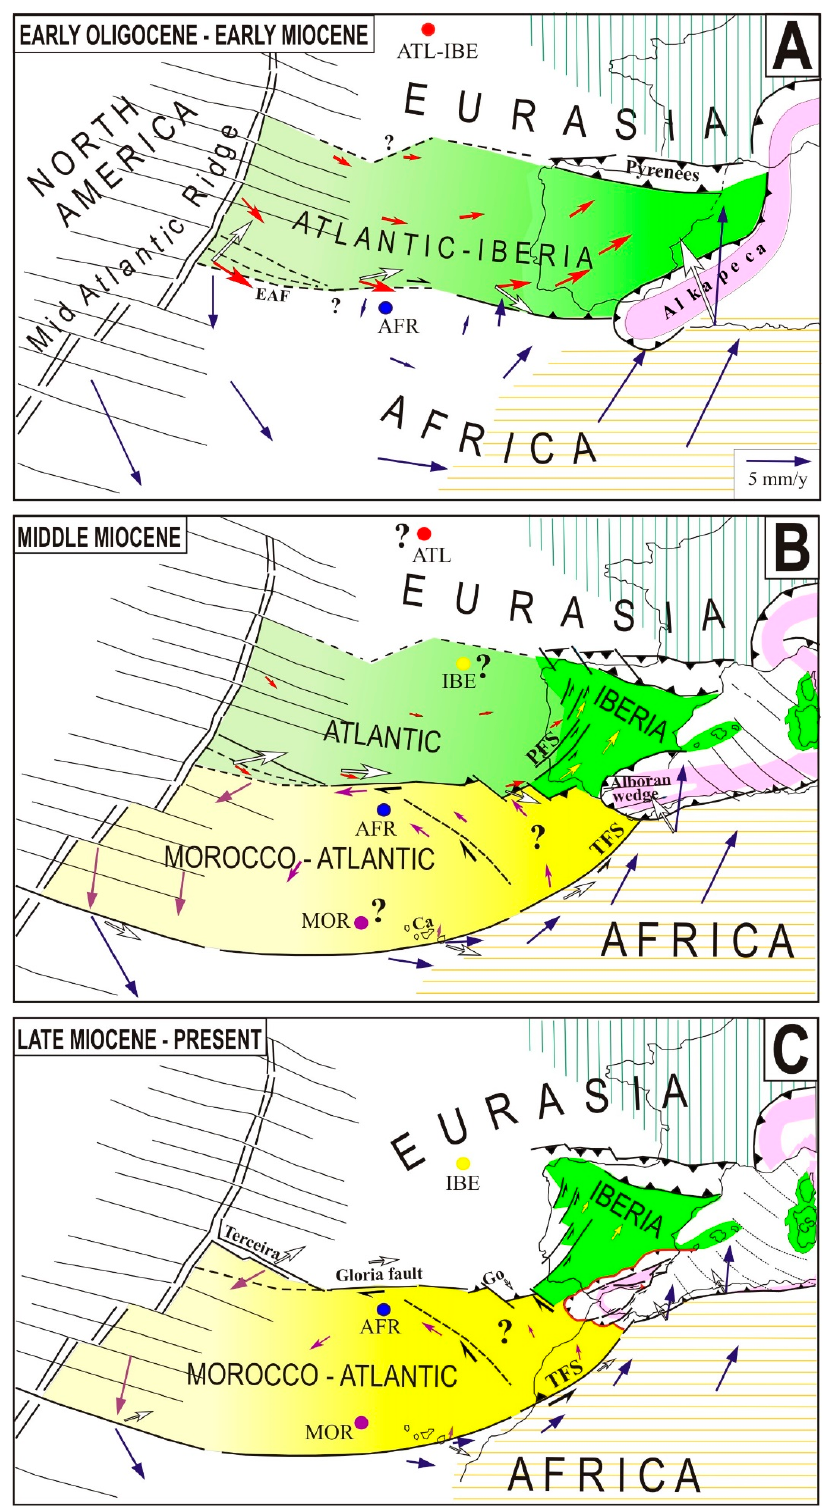
Figure 10. Geodynamic context that led to the detachment of the Morocco–Atlantic block with respect to Africa (modified from [171]). ( A ) About 25 My, the Atlantic–Iberia plate